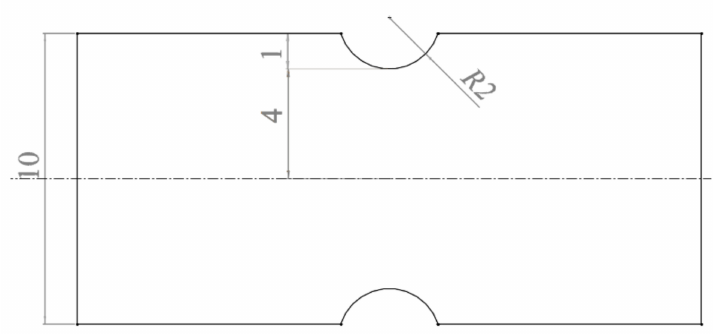
Figure 5. Component with a semicircular notch.